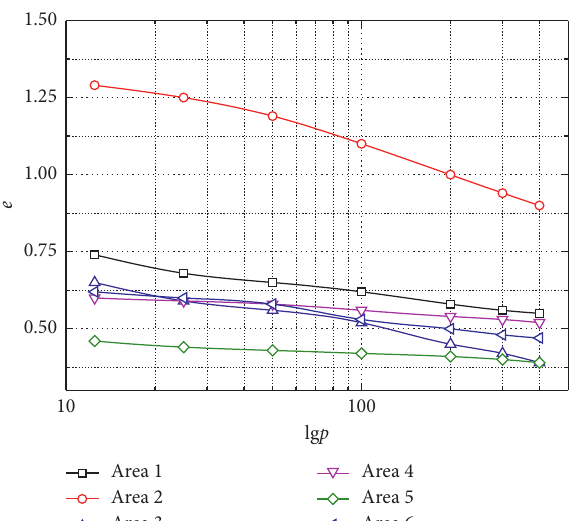
Figure 10: Results of the e -lg p curve in each test